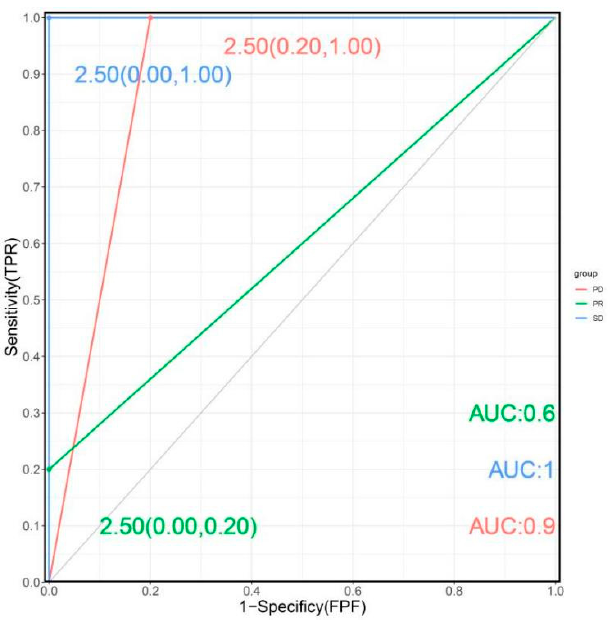
Figure 4. ROC curve of HAMP predicting trichotomous outcomes in HCC patients treated with PD-1 (green: PR; blue: SD; red: PD).